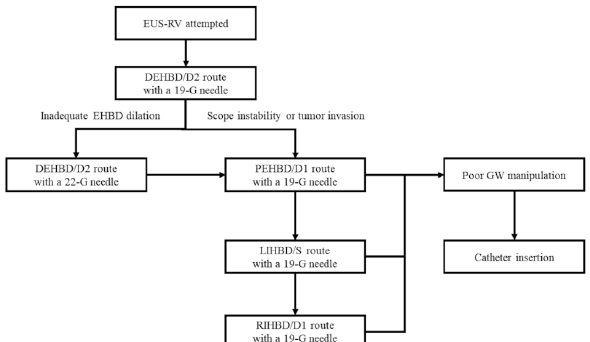
Figure 10. A proposed new algorithm for endoscopic ultrasound-guided rendezvous (EUS-RV). DEHBD / D2: distal extrahepatic bile duct / duodenal second part; PEHBD / D1: proximal extrahepatic bile duct / duodenal bulb; LIHBD / S: left intrahepatic bile duct / stomach; RIHBD / D1: right intrahepatic bile duct / duodenal bulb; GW: guidewire.